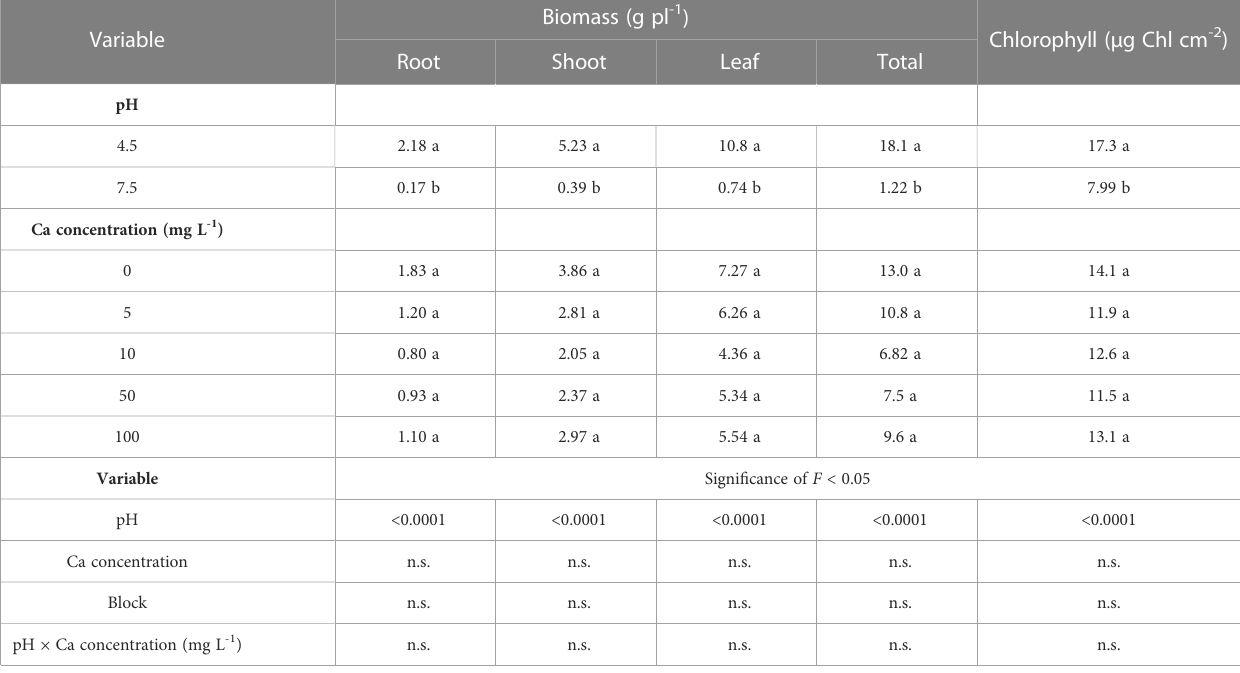
TABLE 1 Effects of pH (4.5 and 7.5) and Ca concentration (0, 5, 10, 50 and 100 mg L -1 ) on the biomass of Southern highbush blueberry ( Vaccinium corymbosum , cv. Windsor) organs (root, shoots, leaf and total biomass) after 12 weeks of growth in nutrient solution and chlorophyll concentrations after 11 weeks of growth in a nutrient solution.